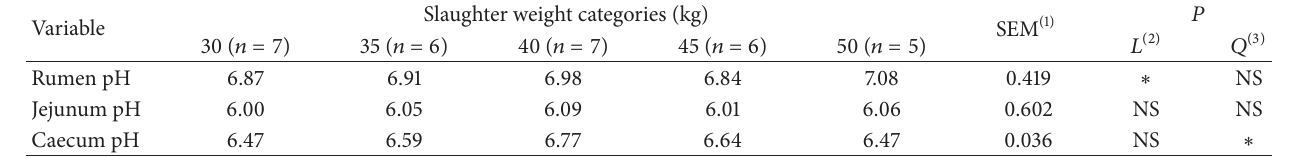
Table 5: Selected segment pH of gastrointestinal tract in Karayaka ram lambs slaughtered at different weights. Slaughter weight categories Variable